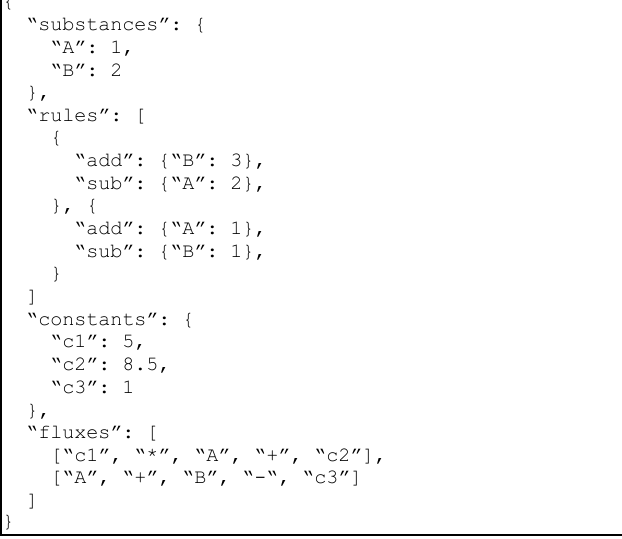
Fig. 3. An example MP system represented by JSON data